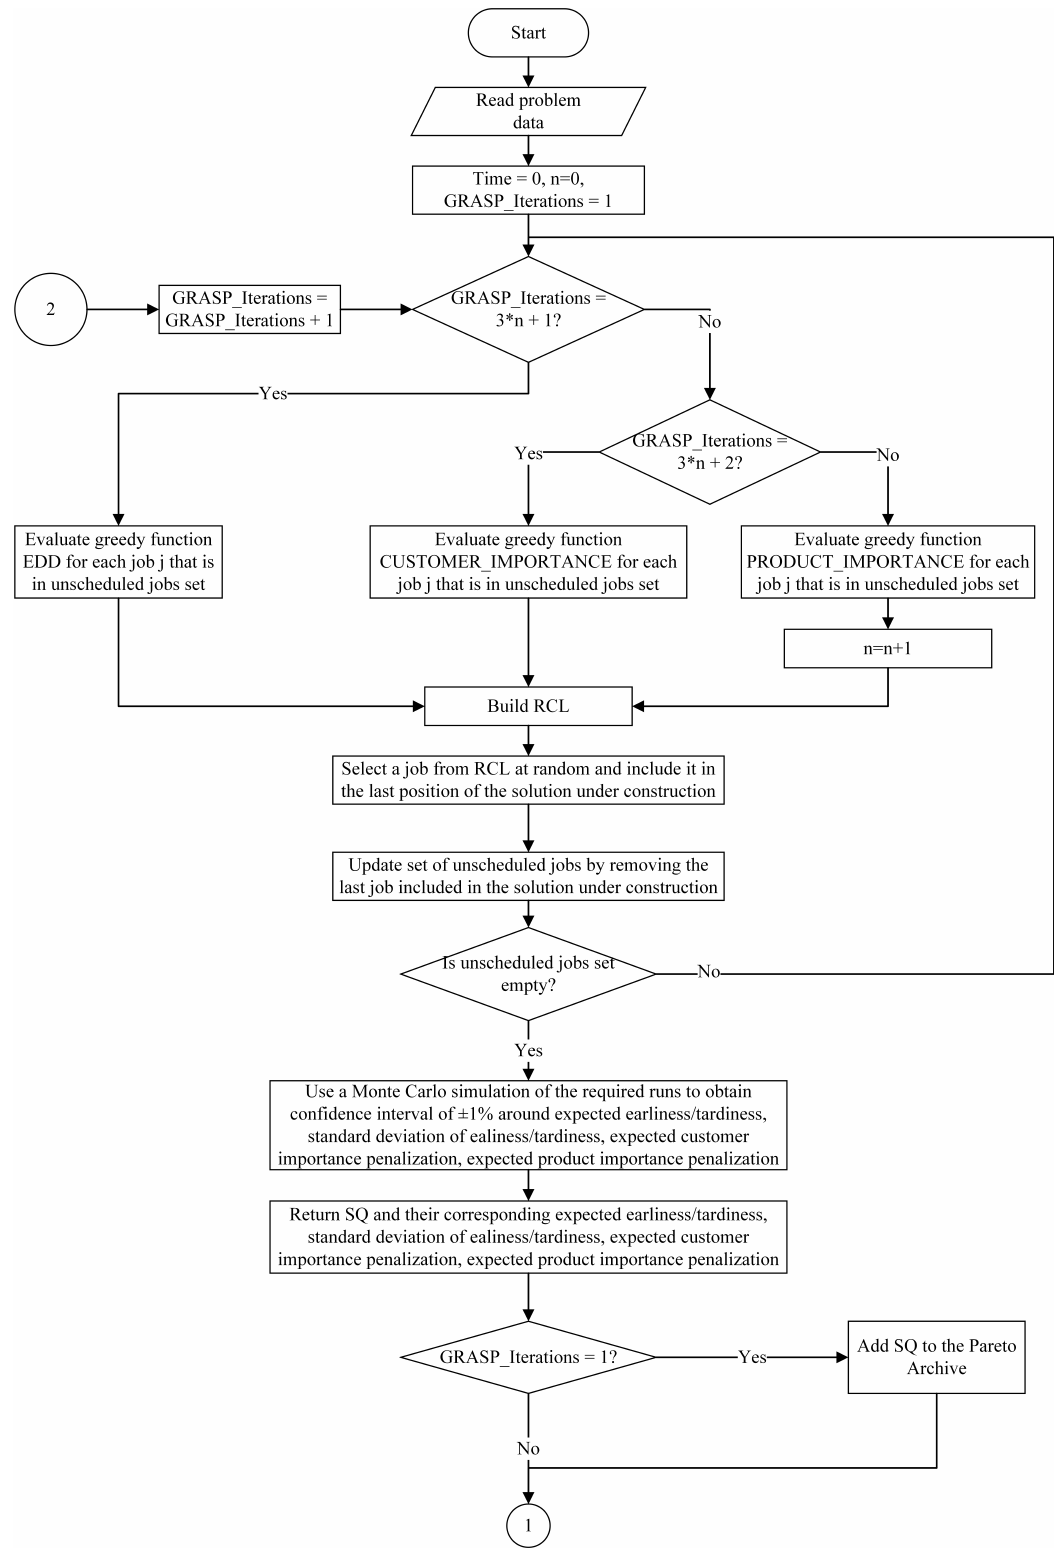
Figure 1. Flowchart of the GRASP construction